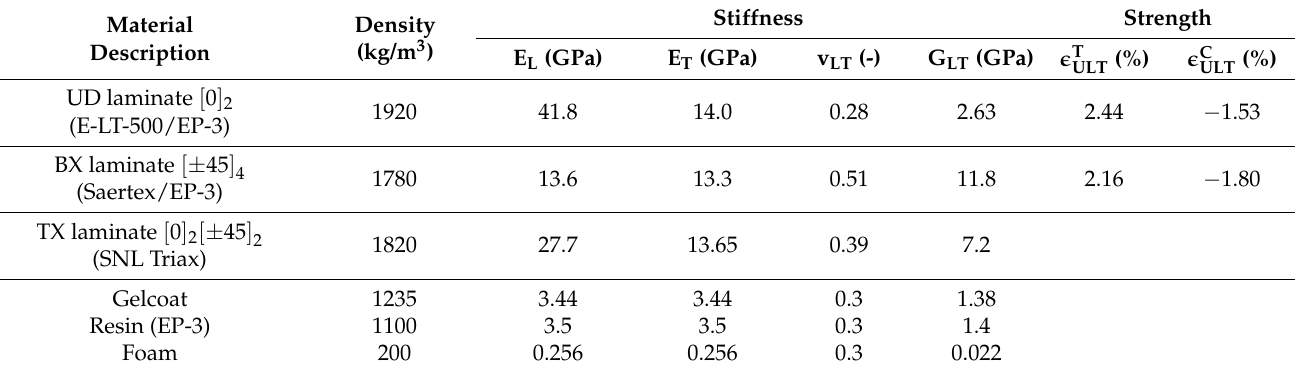
Table 1. Mechanical properties of the layup materials of an SNL